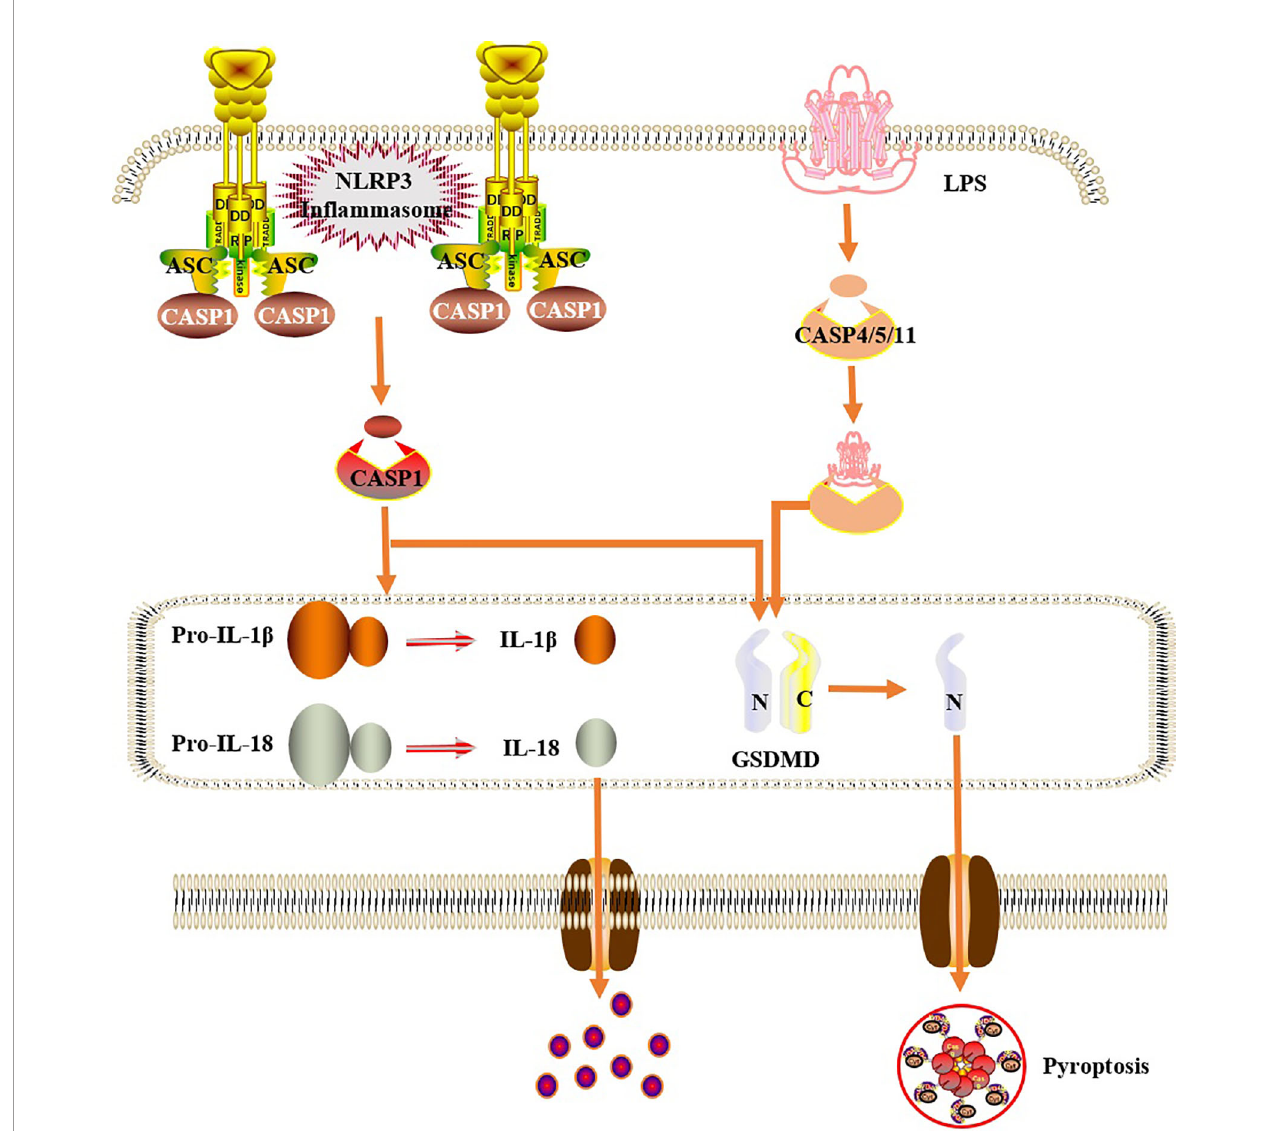
FIGURE 3 | Cells pyroptosis mechanism. In the classical pathway, under the stimulation of bacteria, viruses and other signals, intracellular NLRs act as sensors to recognize these cognate ligand signals, and combine with the precursor of caspase1 through the adaptor protein ASC to form a multi-protein complex and activate caspase-1. Activated caspase-1 cleaves GSDMD to form a peptide segment containing the nitrogen-terminal active domain of GSDMD, which induces cell membrane perforation, cell rupture, release of contents, and in fl ammatory response. Moreover, activated caspase-1 also cleaves the precursors of IL-1 b and IL-18 to form an active structure, which is released outside the cell, recruiting in fl ammatory cells to gather, expanding the in fl ammatory response and mediating cell pyroptosis. In the non-classical pathway, human caspase-4,5 and mouse caspase-11 can be directly activated by contact with bacterial LPS, then cleave GSDMD, and indirectly activate caspase-1, causing